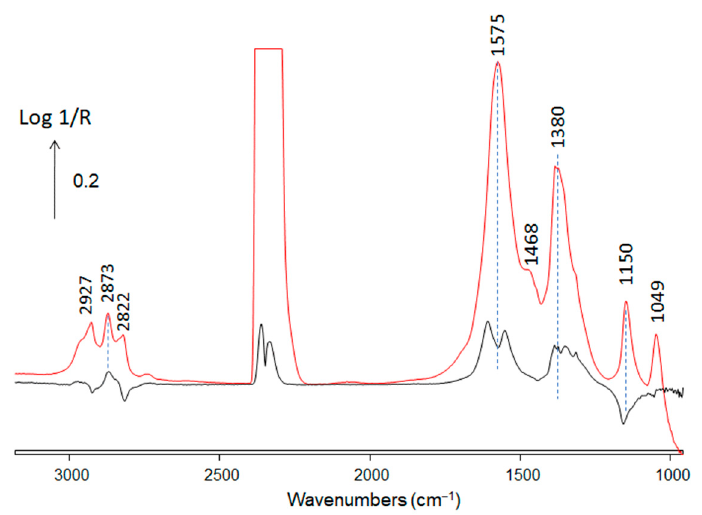
Figure 5. Operando DRIFTS spectra collected (Red) at steady state under CO 2 + H 2 at 220 °C and (Black) difference between the spectra collected after 2 and 20 min after having removed CO 2 from the feed.